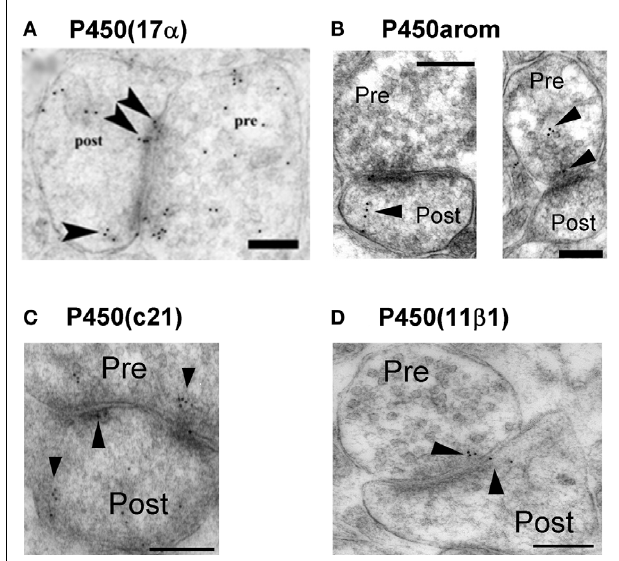
FIGURE 2 | Synaptic localization of cytochromes P450 (17 α ), P450arom, P450 (c21), and P450 (11 β 1) in the hippocampus. Immunoelectron microscopic analysis of the distribution of P450 (17 α ) (A) , P450arom (B) , P450 (c21) (C) , and P450 (11 β 1) (D) within synapses, in the hippocampal CA1 region. Gold particles (indicated by arrow heads) are observed in the presynaptic region (Pre), and the postsynaptic region (Post). Scale bar: 200nm. Modified from Hojo et al. (2004), Higo et al. (2011).